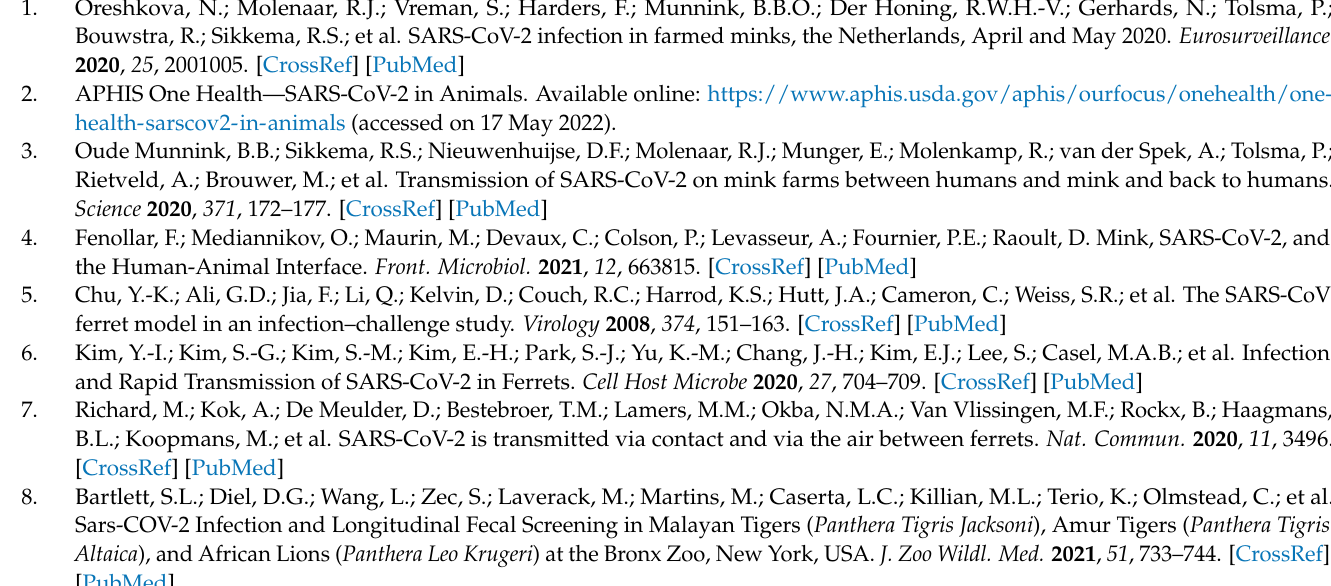
Figure S6. Photomicrographs of lung and nasal cavity of black-footed ferrets ( Mustela nigripes ; BFF) examined at days 3 and 14 post-challenge with SARS-CoV-2. Histological lesion in the lungs were patchy areas of interstitial pneumonia and were found in all three BFF euthanized at 3 days PI and in one ferret euthanized at 14 days PI (A). Suppurative rhinitis was found in three of the BFF, one euthanized at day 3 PI and two at 14 days PI